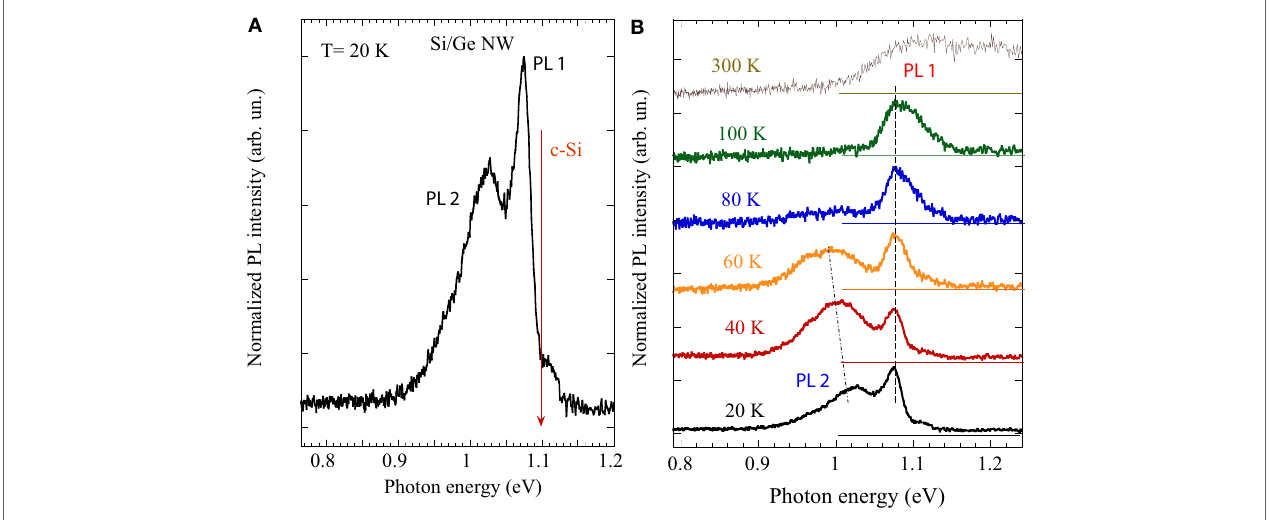
FiGURe 8 | (A) Low-temperature photoluminescence (PL) spectrum of the Si/Ge NW HJs showing major peaks PL1 and PL2 and the location of the main (very sharp) PL peak in c-Si. (B) The PL spectra of the Si/Ge NW HJs at various (marked) temperatures. The PL spectra peak shift with temperature increase is indicated by dashed lines (Wang et al.,